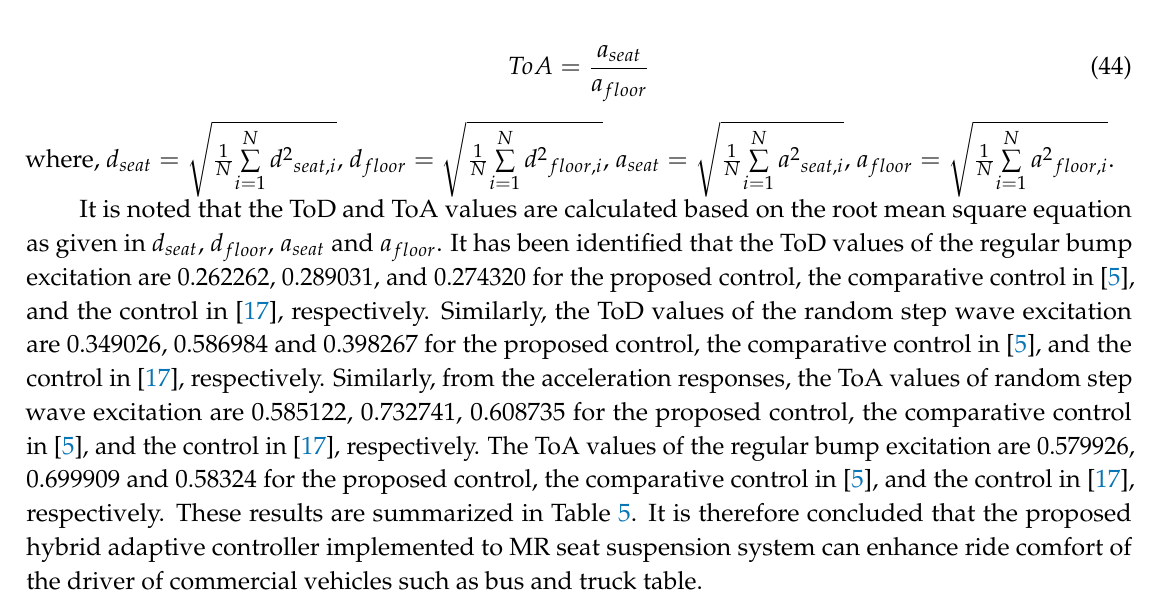
Table 5. Evaluation values of ToD and